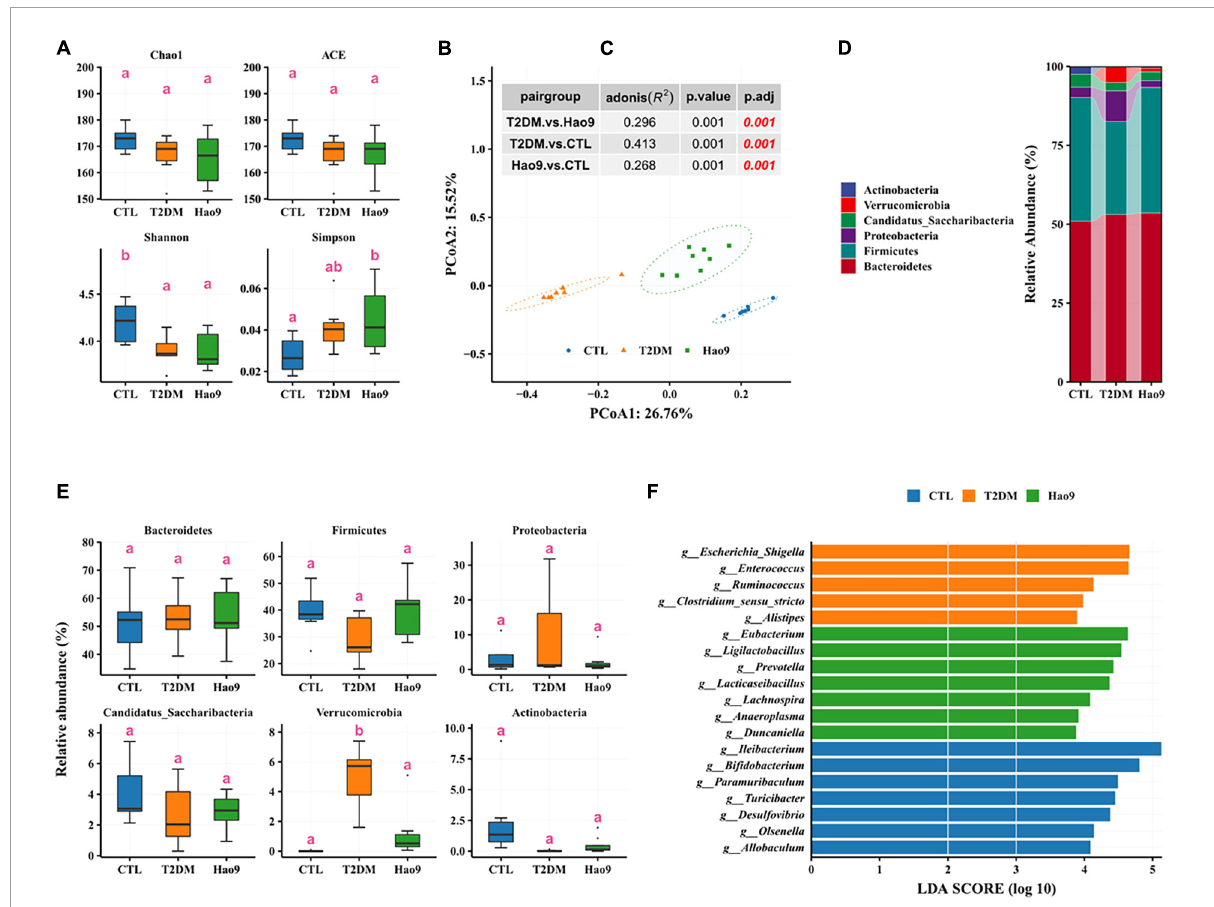
FIGURE5 Effect of Hao9 on gut microbiota in type 2 diabetes mellitus (T2DM) mice at the end of the experiment (week 12). Alpha diversity of gut microbiota in T2DM mice (A) . Principal coordinate analysis (PCoA) based on distance (B) ; the table (C) in the figure showed the results of the adonis significance analysis between groups. Relative abundance of gut microbiota at phylum level (D,E) . Linear discriminant analysis effect size (LEfSe) analysis between pair groups was used to analyze the relative abundance (F) of gut microbiota at the genus level. Different superscript letters denote groups that are statistically different ( p <